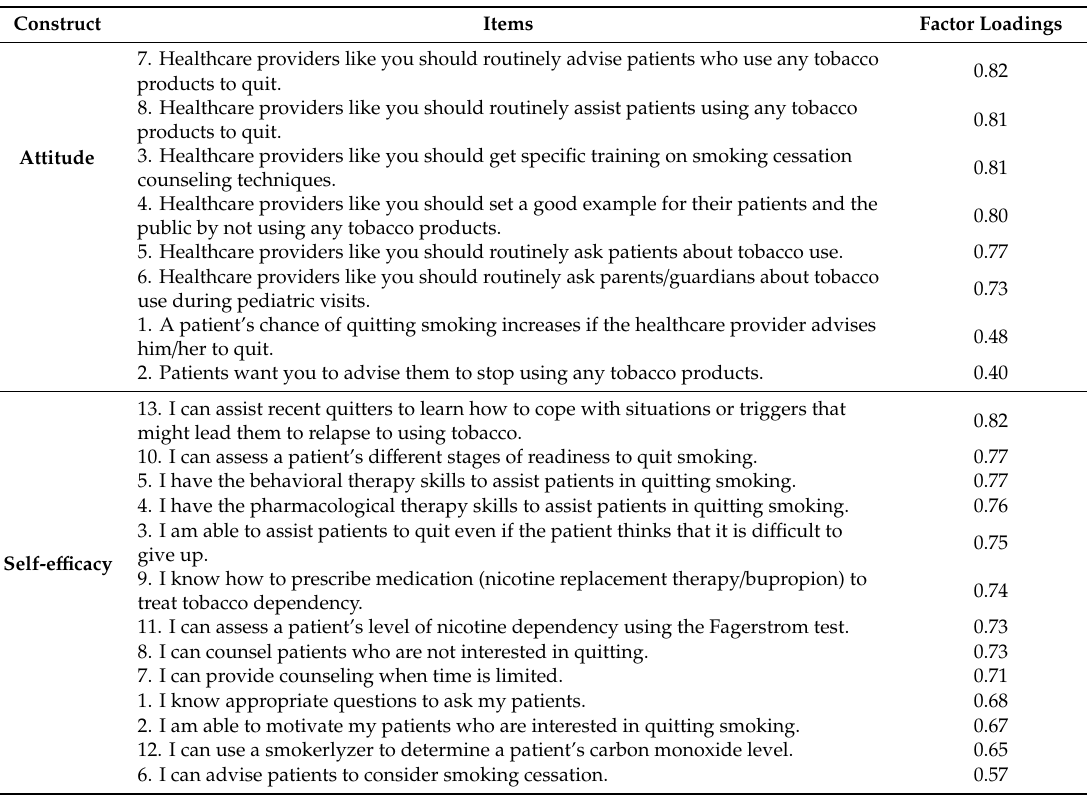
Table 5. Rotated factor